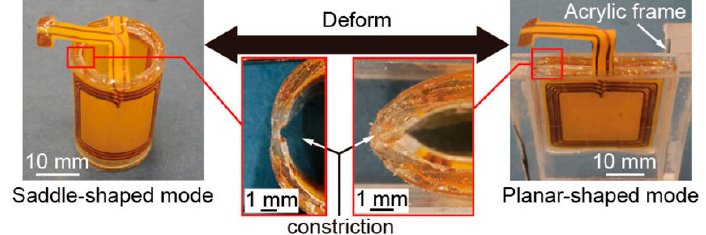
Figure 4. Photographs of the fabricated micro saddle coil. The coil deforms from